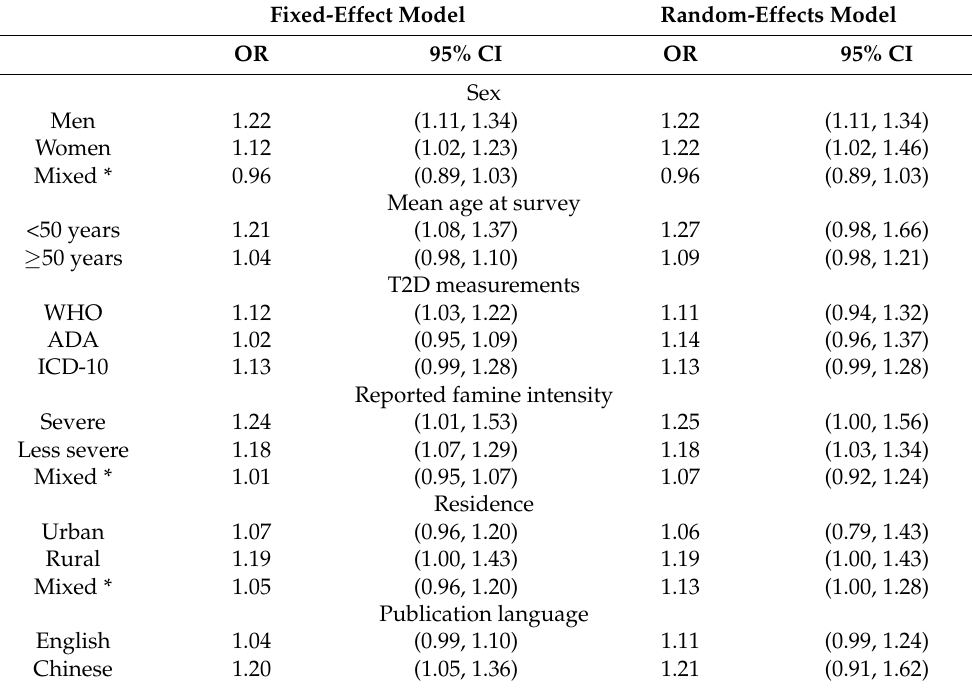
Table 2. Subgroup analysis of effect estimates by selected characteristics comparing famine births to combined pre- and postfamine